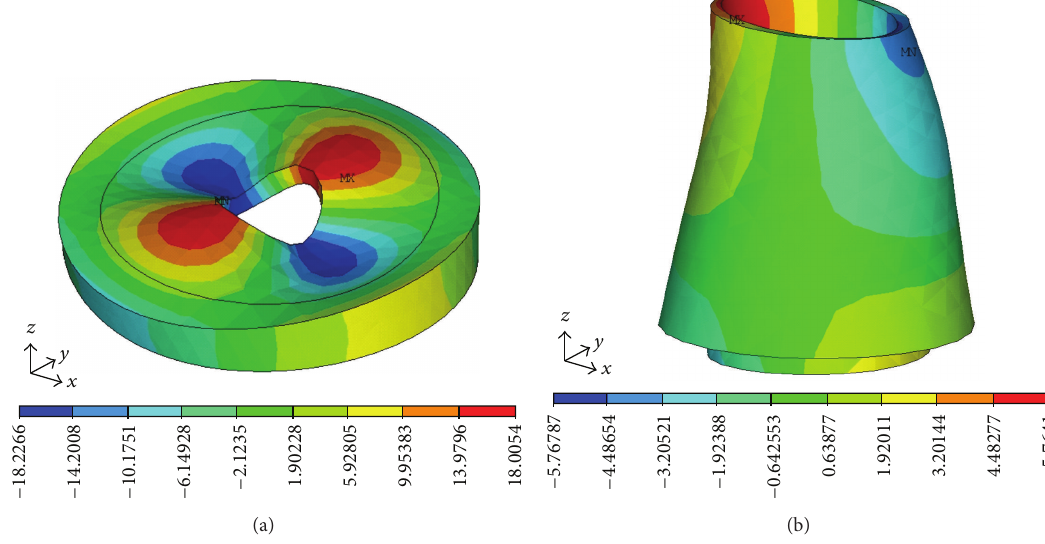
Figure 4: Modal shapes of the analyzed actuators: symmetrical ring type (a), cone type (b).